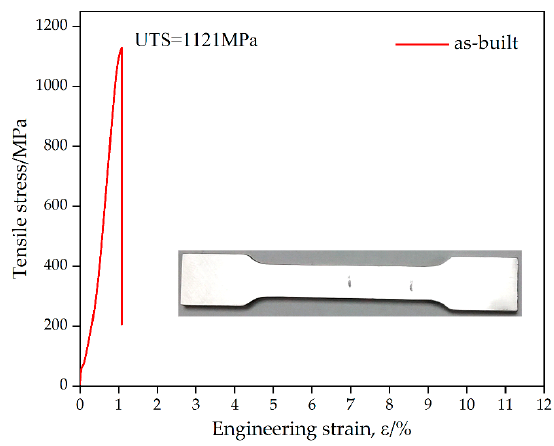
Figure 14. The tensile properties of 90W ‐ 7Ni ‐ 3Fe fabricated by SLM.